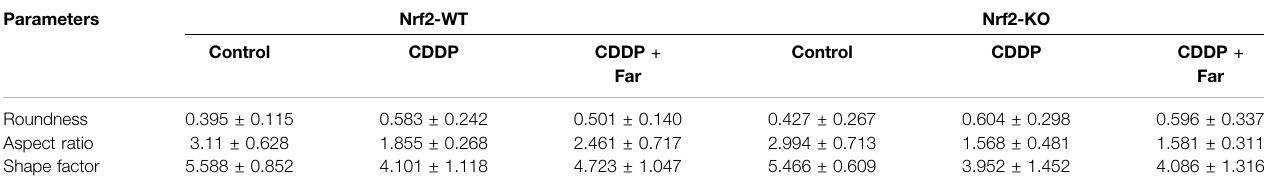
TABLE 3 | Contour measurements of mitochondria.